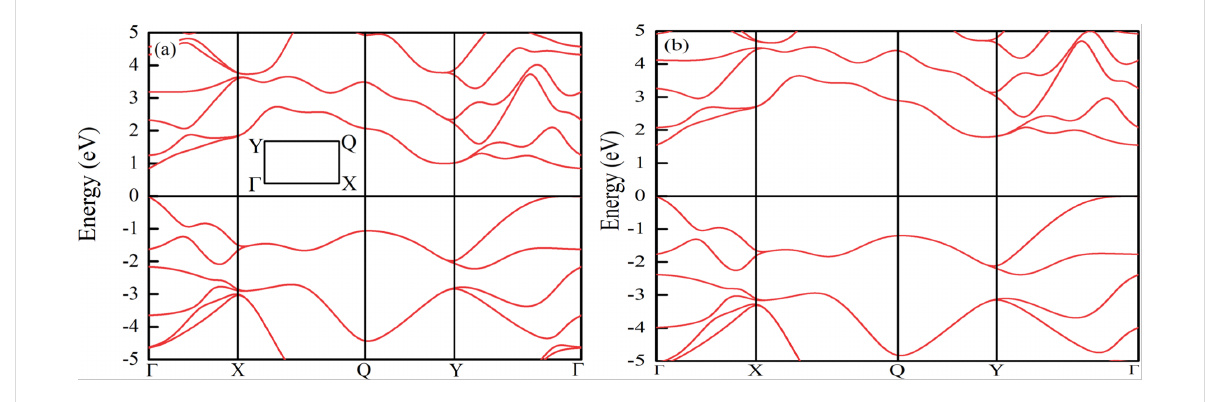
Figure 8: Band alignment of phosphorene calculated by using (a) the GGA of PBEsol and (b) HSE06. The inset shows the path in the Brillouin zone. The Fermi level is shifted to